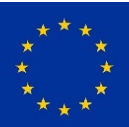
Figure S1: Elastase activity in blood serum of mice under high-fat high-cholesterol diet, high-fructose diet, and under the influence of blocker of PMN